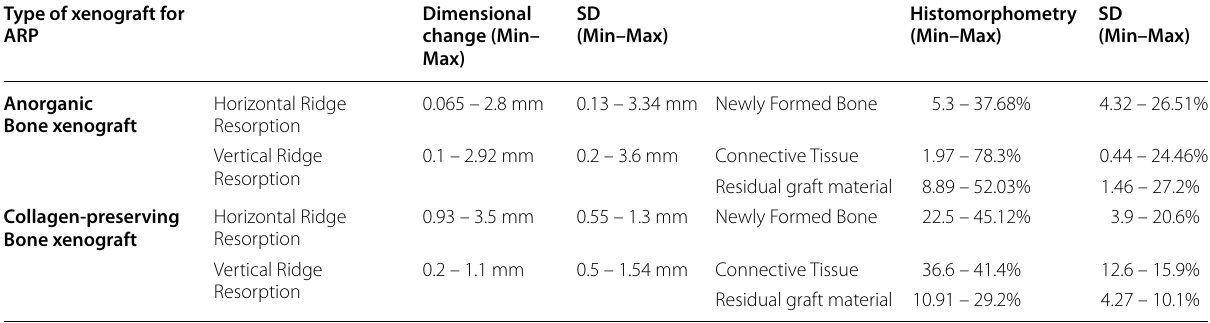
Table 6 Dimensional and histomorphometric clinical outcomes obtained by grafting post-extraction sockets with ABXs versus CBXs for